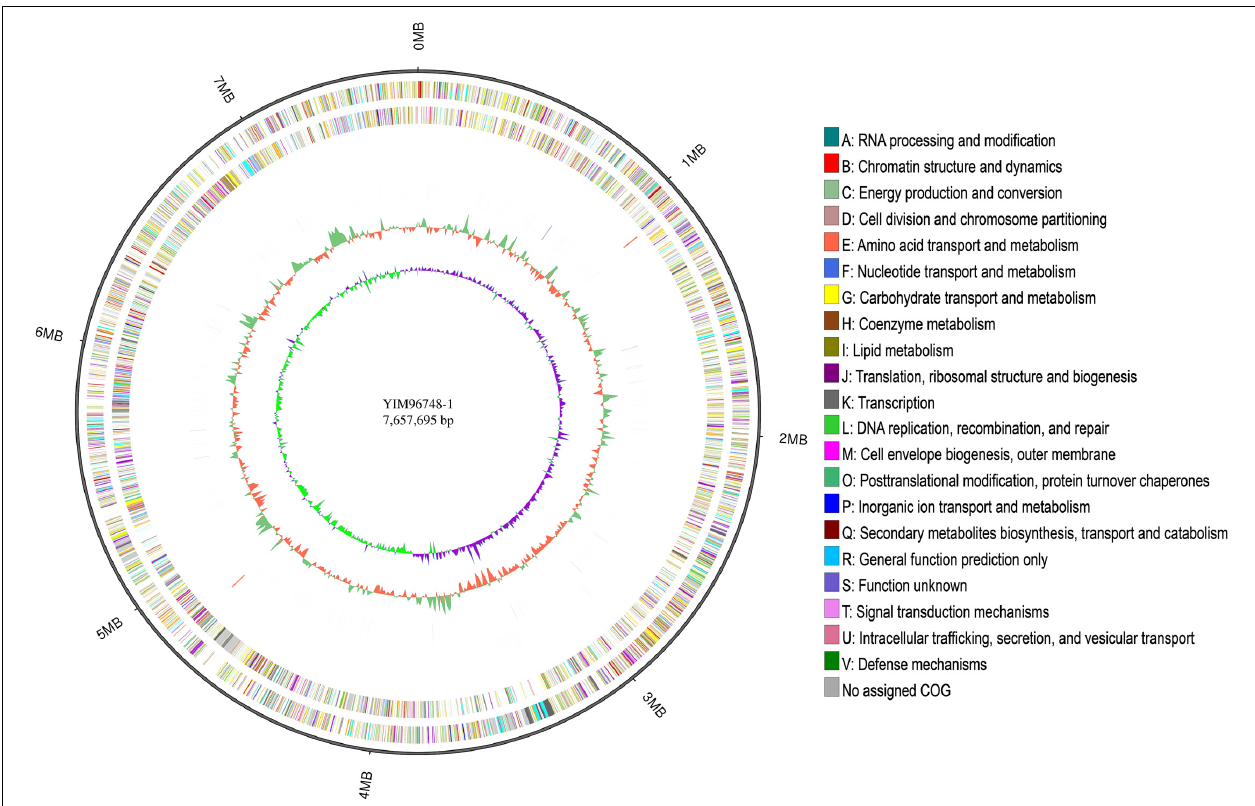
FIGURE 3 | Circular genome map of YIM 96748 T . Tracks (from inner to outer ): 1 , Genome size; 2 , forward strand gene, colored according to Clusters of Orthologous Groups of proteins (COG) classification; 3 , reverse strand gene, colored according to COG classification; 4 , forward strand ncRNA; 5 , reverse strand ncRNA; 6 , repeat; 7 , GC content; and 8 , GC skew.